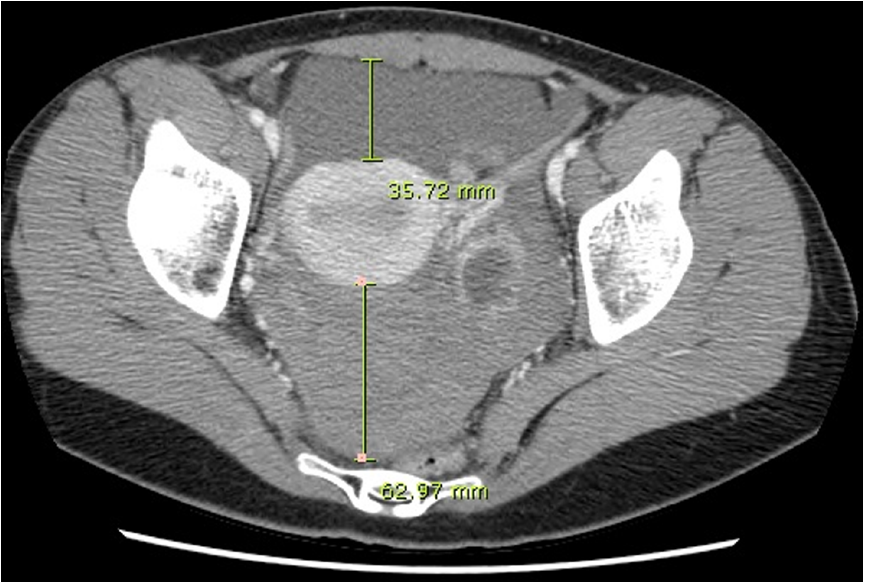
Figure 1. CT quantification of hemoperitoneum. The depth in the anterior cul-de-sac and the posterior cul-de-sac are defined the distance from the anterior peritoneum to the anterior uterine wall and the distance from the posterior uterine wall to the rectum, respectively.